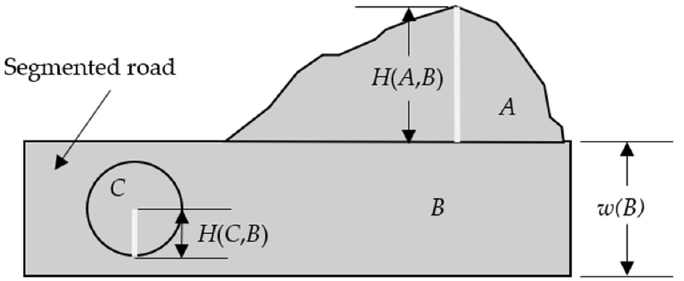
Figure 4. A sketch map for the Hausdorff distance where A , B , and C represent three different road clusters, and w ( B ) is the mean value of width feature for all pixels in B .